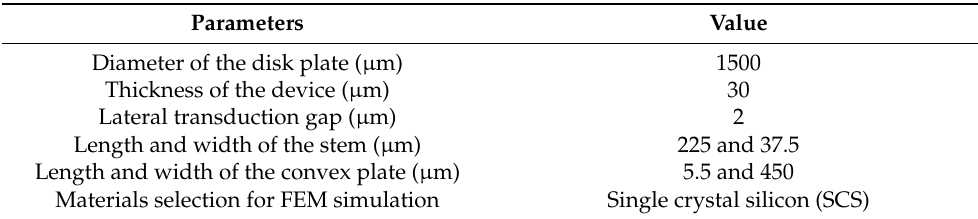
Figure 9. A 2-DoF electrostatically coupled BAW disk resonator system operating in different modes simulated in COMSOL. ( a ) Out-of-phase mode 1; ( b ) In-phase mode 1; ( c ) Out-of-phase mode 2 (WG mode); ( d ) In-phase mode 2 (WG mode). The deformation of resonators is magnified. In reality, the frequencies of the two modes are prone to be aliased due to the limited Q factor. Table 4. Dimensions and materials of a 2-DoF electrostatically coupled BAW square resonator system modeled in COMSOL.